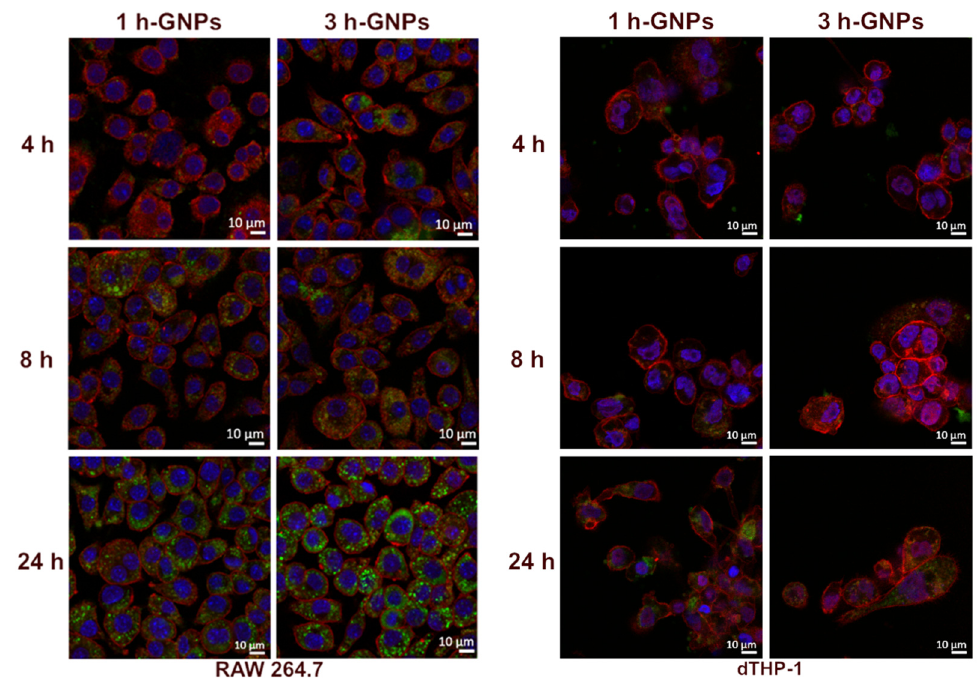
Figure 5. Cellular interaction of GNPs with RAW 264.7 and dTHP-1 cells, after 4, 8 and 24 h incubation of 1 (soft) and 3 h (stiff) crosslinked GNPs. The blue signal corresponds to nuclei stained with DAPI, the red signals correspond to cell membranes stained with WGA-Alexa Fluor TM 633, and the green signals originate from 150 kDa FITC–dextran-loaded GNPs.